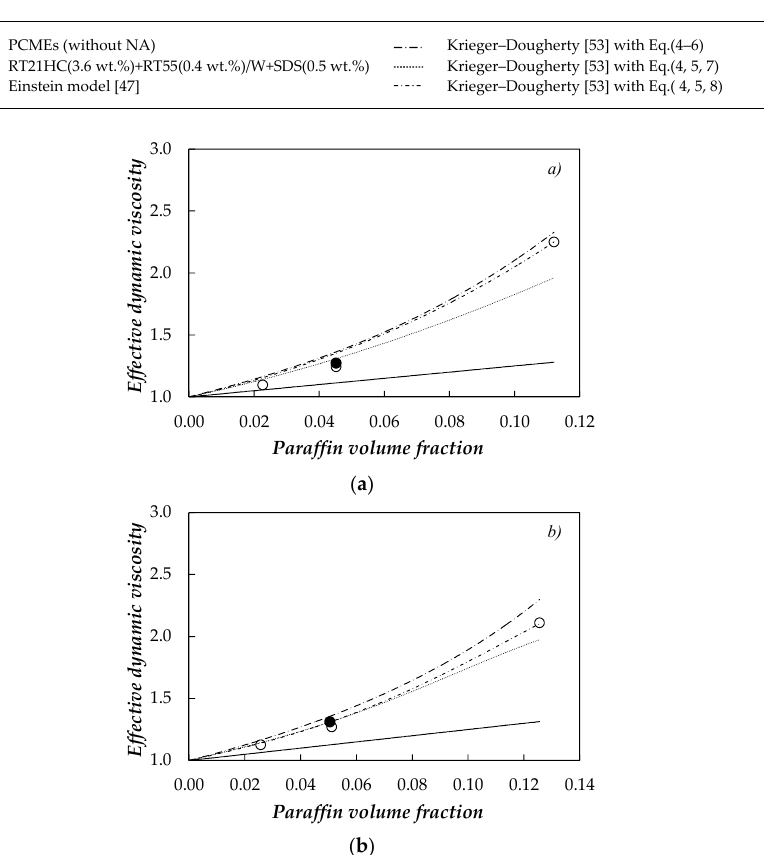
Figure 3. Volume fraction, φ , dependence of effective dynamic viscosity, µ r = µ / µ water+SDS , at ( a ) 278.15 K and ( b ) 303.15 K.